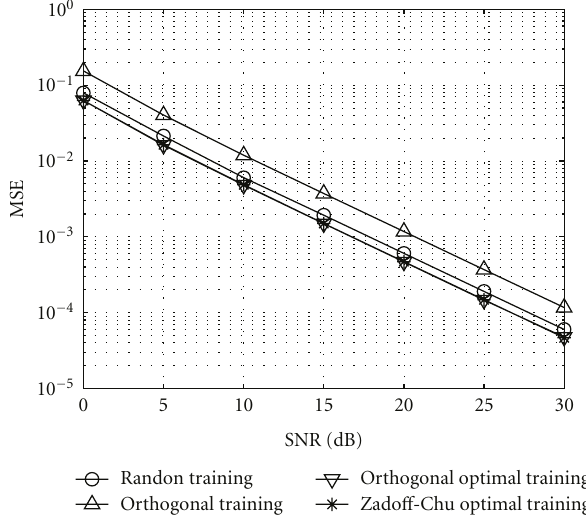
Figure 1: MSE performance for di ff erent SNR.